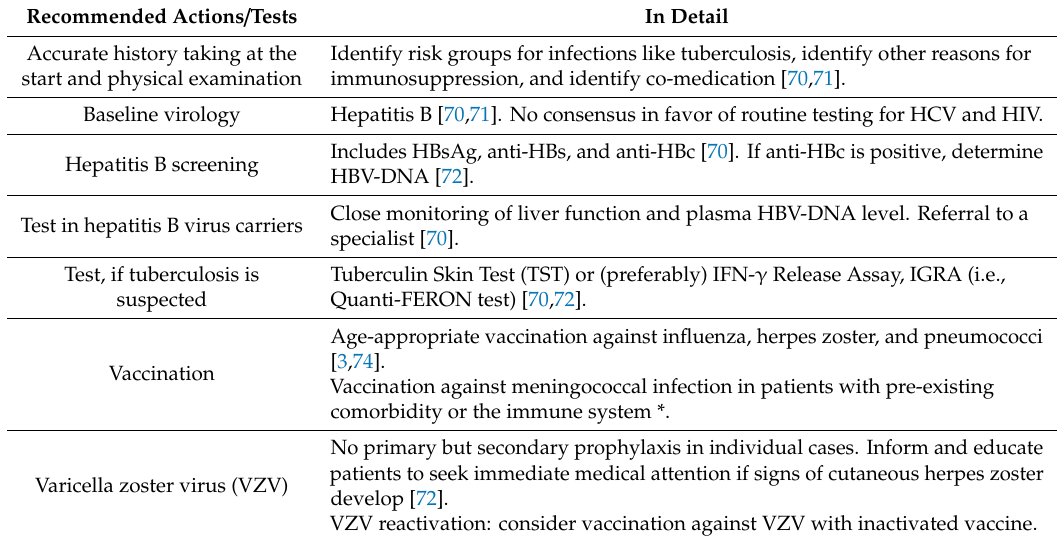
Table 2. Recommendations for avoiding complications from ruxolitinib-associated infections in polycythemia vera